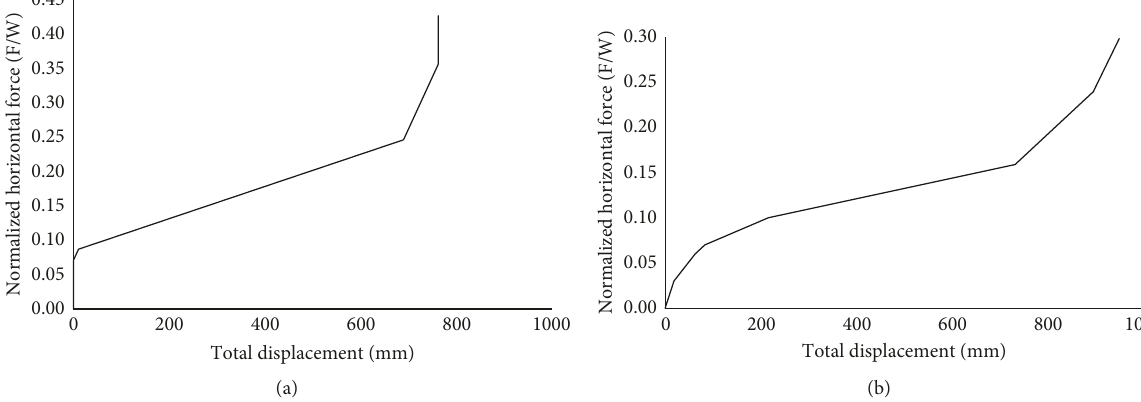
Figure 2: (a) Computed force-displacement curves for the examined bearing configurations: (a) TFPBs and (b)